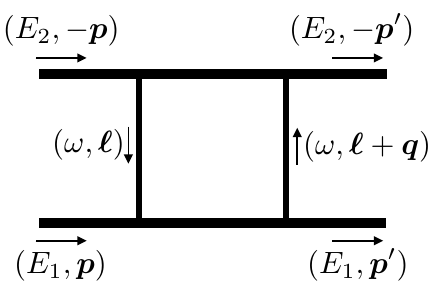
Figure 16 . The one-loop box diagram. The thick and thin lines represent massive and massless particles,